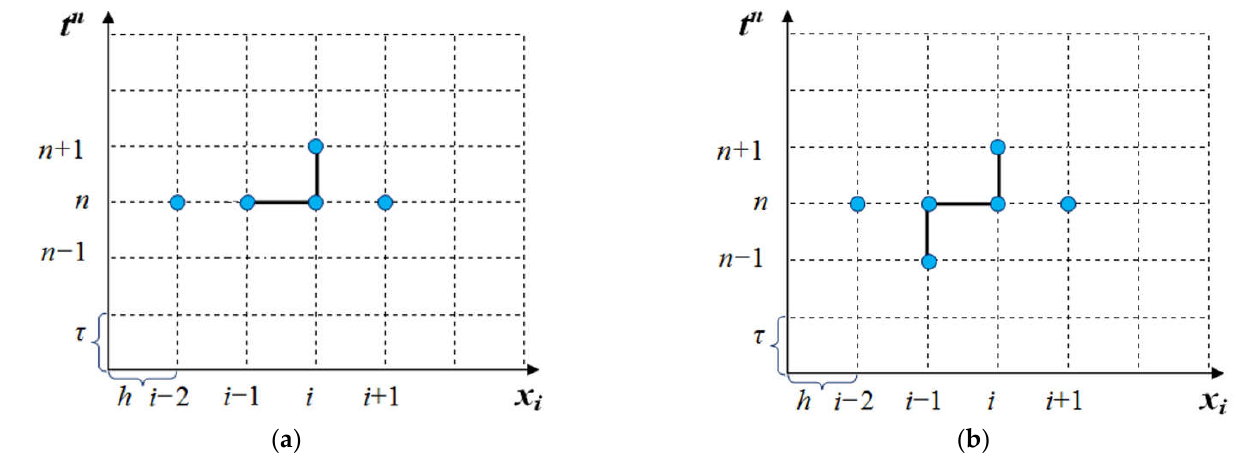
Figure 1. Extended templates of the “Left Corner” ( a ) and “Upwind Leapfrog” ( b ) schemes for the KdV equation.